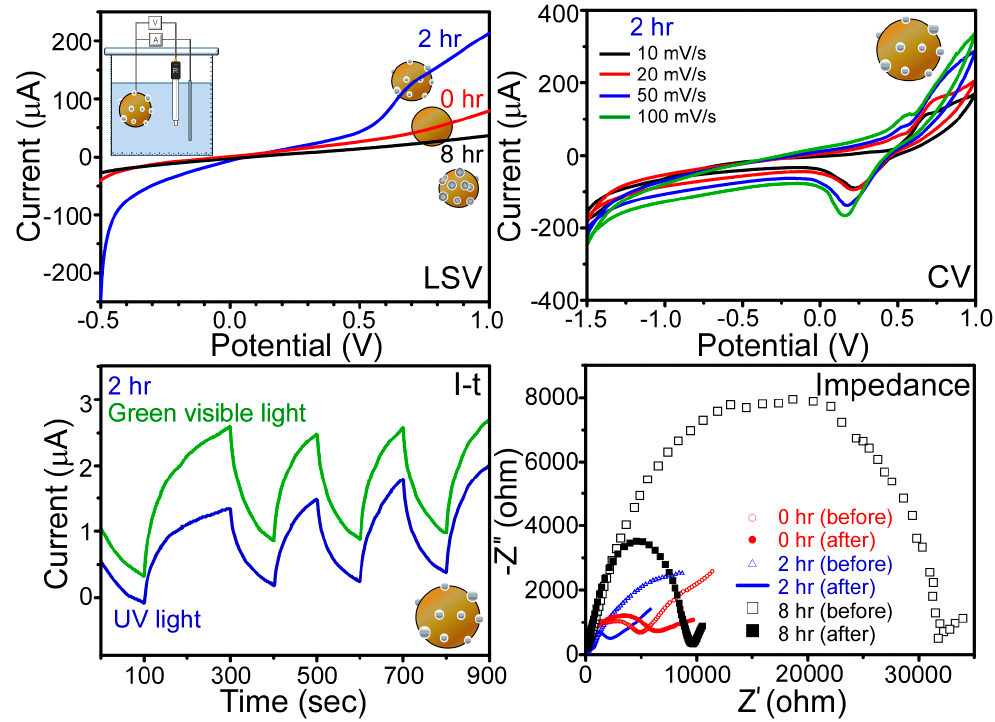
Figure 10. Linear sweep voltammograms (LSVs), cyclic voltammograms (CVs), and current-time (I-t) amperometry curves under cyclic ON and OFF light conditions at 0.3 V, and impedance curves for selected bare boron, B@Ti (2 h), and B@Ti (8 h) samples.